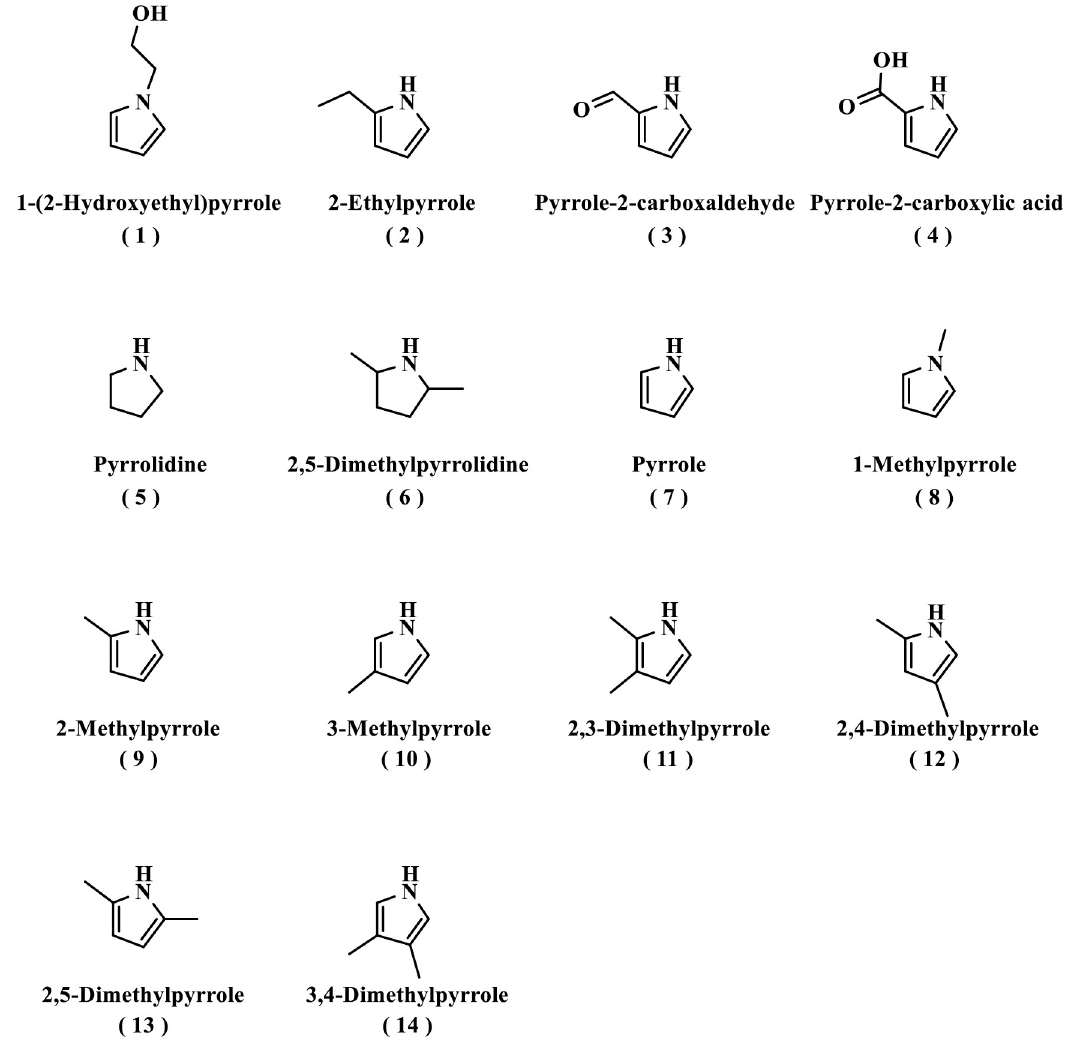
Fig 14. Additional pyrrole derivatives tested to identify the structure-activity relationship of MPPB with viability and relative cell-specific productivity in rCHO cell cultures.